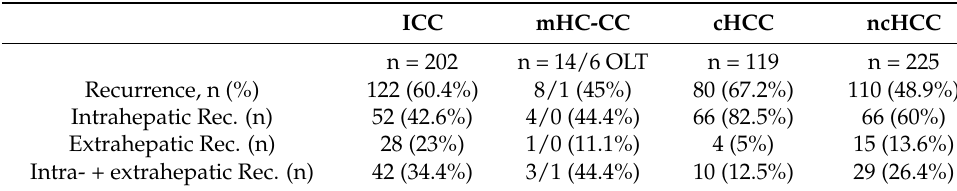
Table 3. Location of tumor